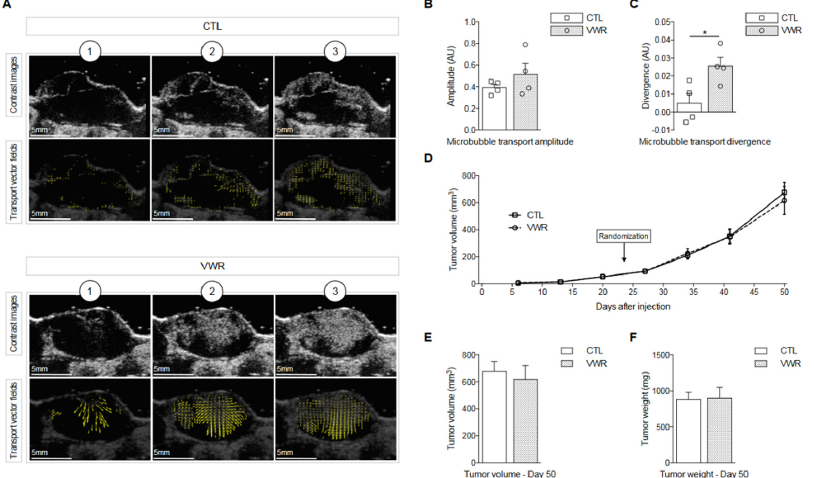
Figure 2. VWR modulates microbubble transport in the tumor but does not impact tumor growth. ( A ) Representative images of microbubble transport estimates from the DCEUS in CTL and VWR mice acquired at (1) 0 s, (2) 1 s and (3) 2 s after bolus arrival. For each experimental group, the first row shows contrast images and the second row displays estimated apparent transport fields; ( B ) Quantification of microbubble transport amplitude; ( C ) Quantification of microbubble transport divergence; ( D ) Tumor volume (in mm 3 ) evolution; ( E ) Tumor volume (in mm 3 ) on the day mice were euthanized (day 50); ( F ) Tumor weight (in mg) on day 50. Data are represented as means ± SEM. * p < 0.05.